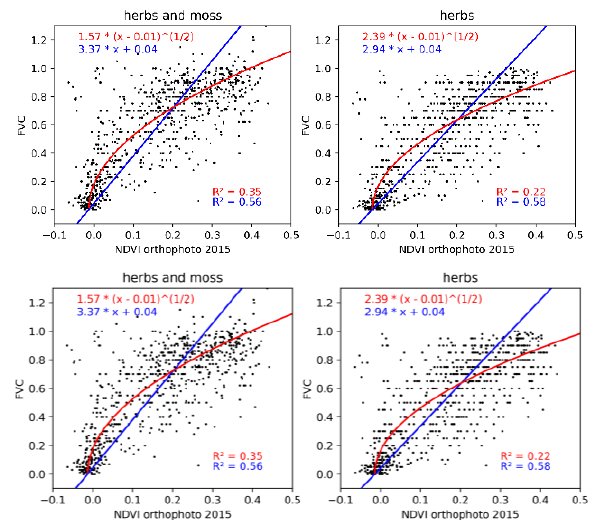
Figure 6. Relationship between NDVI (orthophoto 2015) and FVC (measured field data). Fitted functions are indicated in red (square root-function) and blue (linear model).